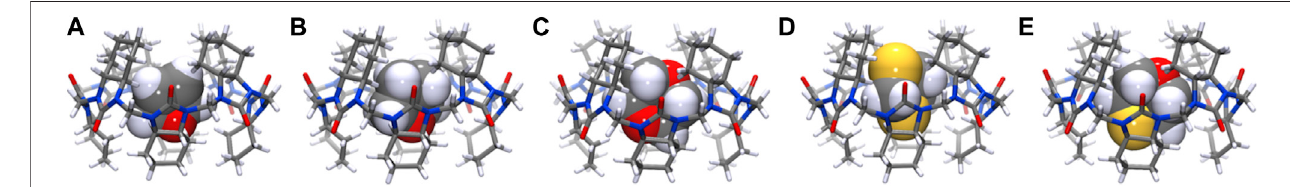
FIGURE 2 | Crystal structures of cycHC[8] inclusion complexes with neutral heterocycles with increasing packing coef fi cient order: 8 @cycHC[8] (A) (PC 0.51), 7 @ cycHC[8]; (B) (PC0.54), 6 @cycHC[8]; (C) (PC0.61), 1 @cycHC[8]; (D) (PC0.66), 3 @cycHC[8]; (E) (PC0.69).Theirpackingcoef fi cientvaluesaretheratiosbetween V guest to V cavity (host), re fl ecting the space fi lled by the encapsulated guest in the host cavity (Mecozzi and Jr, 1998). For more details, see Supplementary Material S13 .